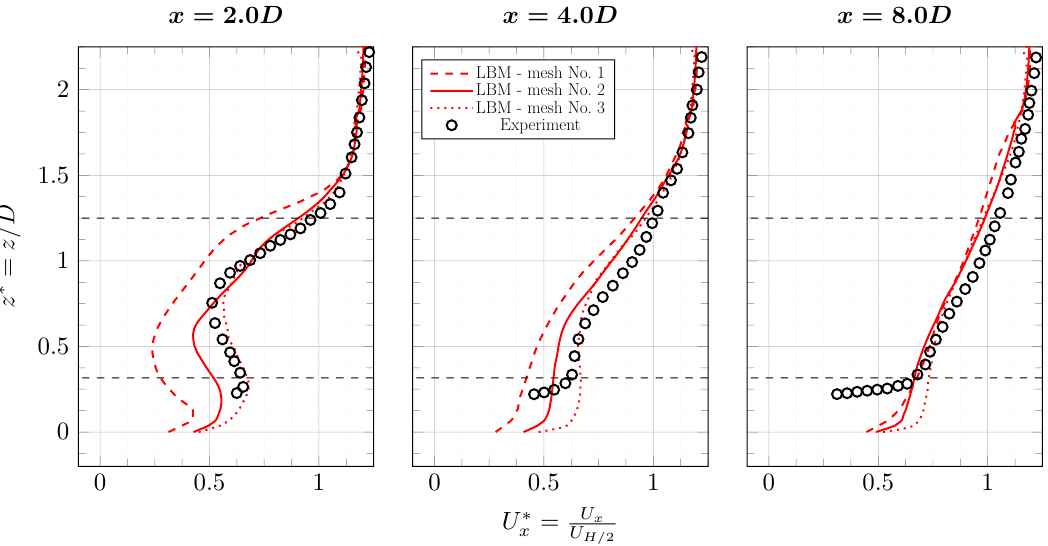
Figure 8. Average axial velocity z profiles in the wake of the tidal turbine [27] at TSR = 1.1: experimental data and ALM-LBM results for the three meshes. Turbine footprint is drawn in horizontal black